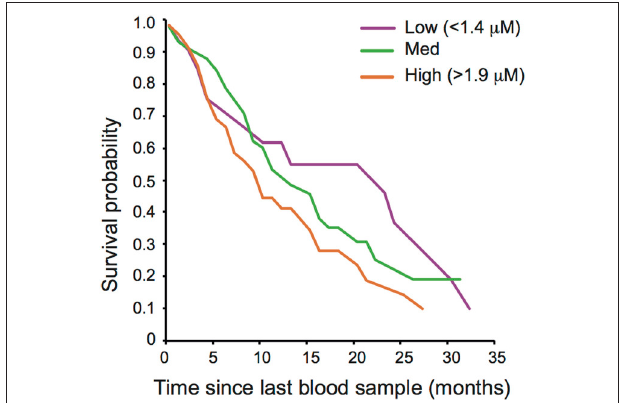
FIGURE 1 | Oxidative damage and adult post-sampling survival of wild banded mongooses. Plasma oxidative lipid damage (malondialdehyde; MDA) concentration predicted adult survival. Survival curves are drawn for illustrative purposes for individuals with low ( > 1.4 µ M), medium and high ( > 1.9 µ M) levels of